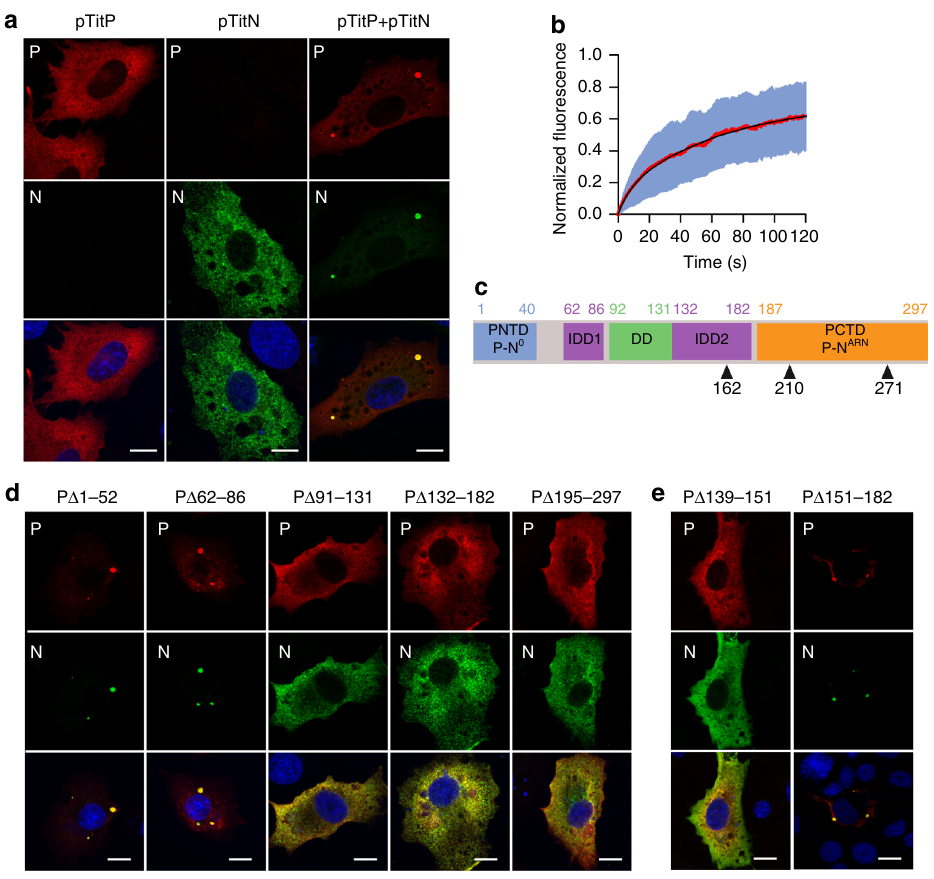
Fig. 6 Co-expression of N and P leads to the formation of inclusion bodies recapitulating NB properties. a BSR-T7/5 cells were co-transfected for 24 h with plasmids pTit-P and pTit-N (in equimolar concentration). N was revealed with a mouse monoclonal anti-N antibody followed by incubation with Alexa-488 donkey anti-mouse IgG and P was revealed with a rabbit polyclonal anti-P antibody followed by incubation with Alexa-568 donkey anti-rabbit IgG. DAPI was used to stain the nuclei. Scale bars correspond to 15 µ m. b Fluorescence recovery after photobleaching (FRAP) of P-mCherry localized in inclusion bodies in BSR-T7/5 co-expressing P-mCherry and N. The diameter of the photobleached regions was 2.7 µ m. FRAP data were corrected for background, normalized to the minimum and maximum intensity, and the mean is shown with error bars representing the SD. Experimental curves were fi tted with a two-exponential model (in black). Data were from 21 FRAP events (Supplementary Fig. 6). c Domain organization of RABV P polypeptide chain. P contains an N-terminal domain which binds to N 0 (PNTD:P-N 0 ), two intrinsically disordered domains (IDD1 and IDD2), a dimerization domain (DD)